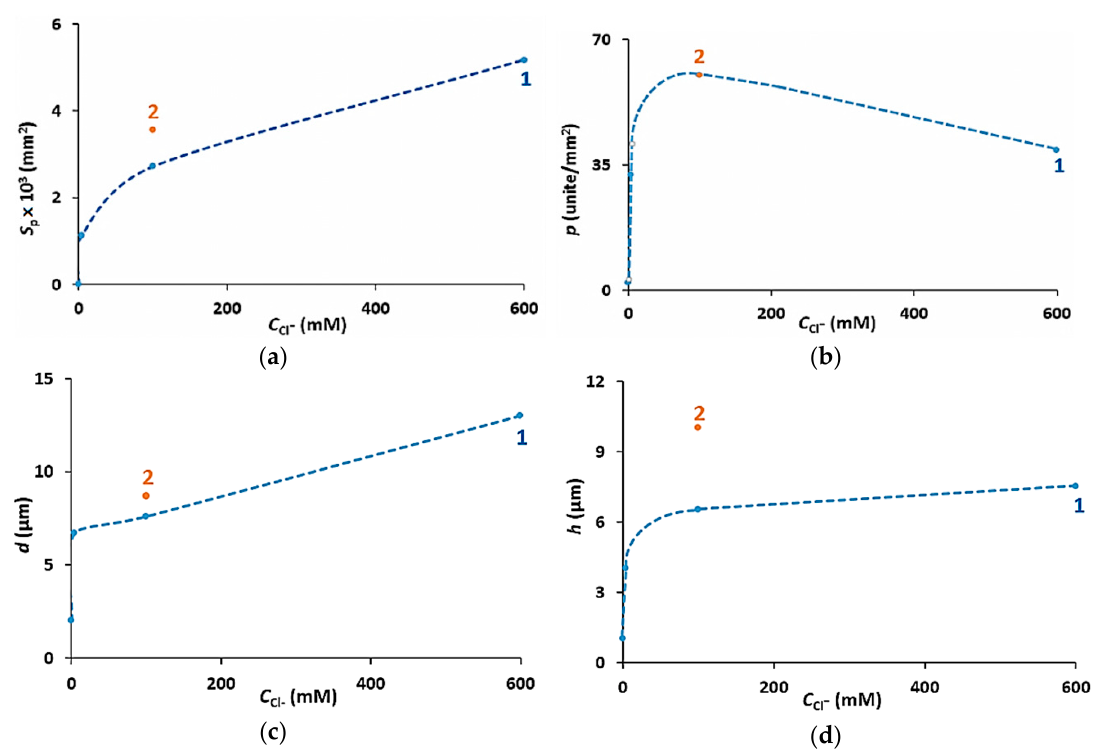
Figure 3. Variation in the total area S p ( a ); density ρ ( b ); mean diameter d ( c ); and maximum pit depth h ( d ) as a function of the concentration of chloride ions (curves 1) in borate buffer electrolyte. Point 2 —non-buffered 0.1 M NaCl aqueous solution. The setup consists from 72 cycles of SACP (the potential switched between − 1 V vs. SHE (duration 10 min) and − 0.3 V vs. SHE (duration 3 min).